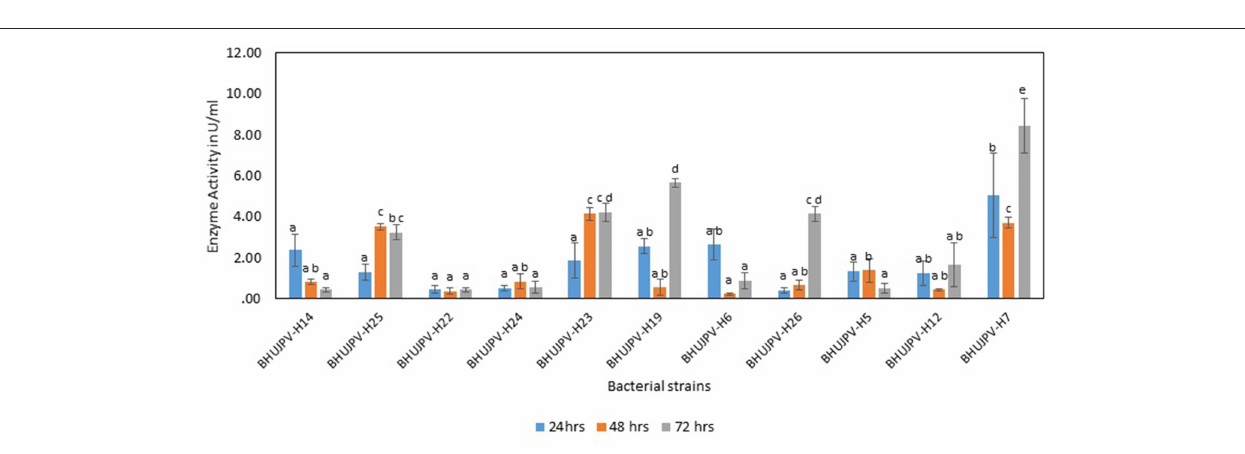
Frontiers in Energy Research |